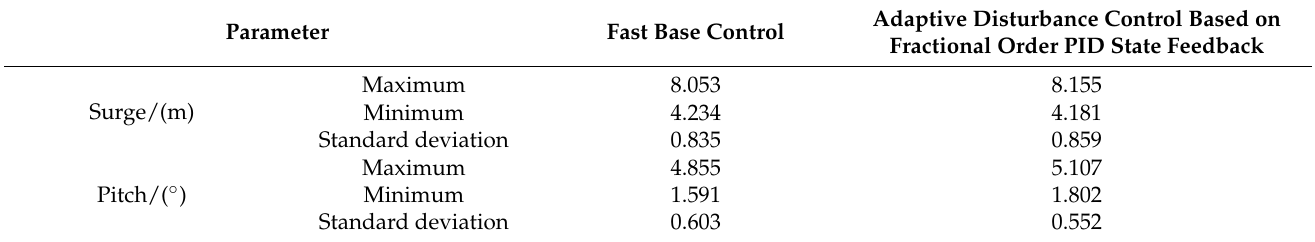
Figure 11. Comparison of heave displacement under two different control algorithms.